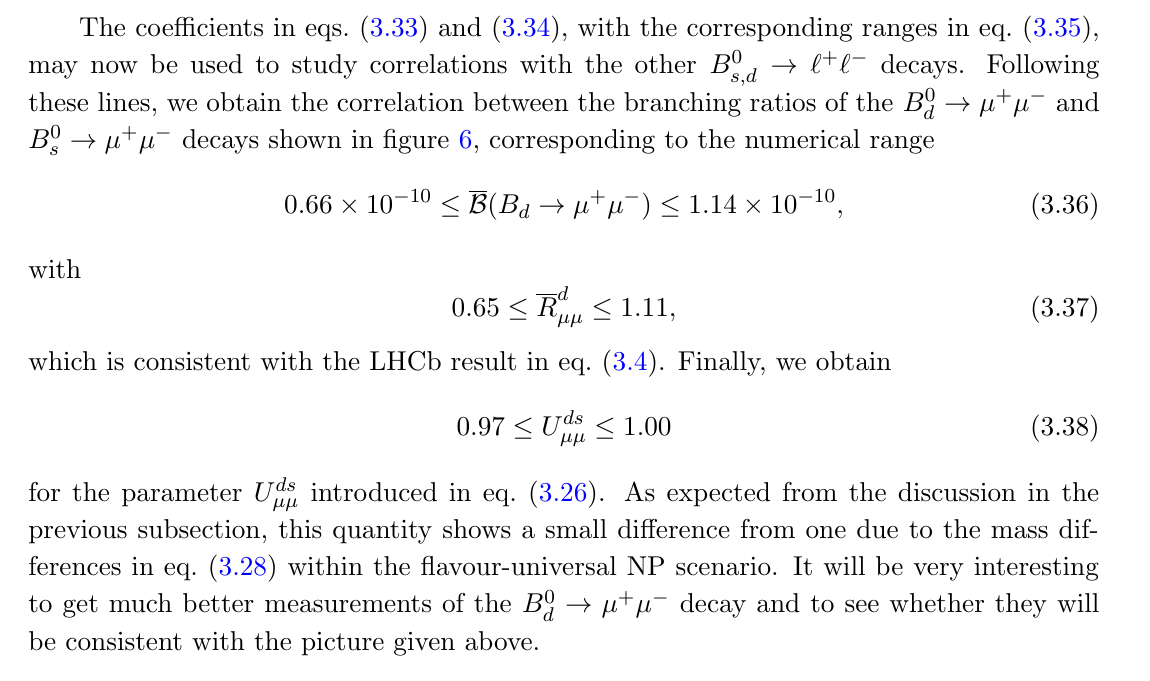
Figure 6 . Correlation between the branching ratios the considered (cid:13)avour-universal NP scenario. The vertical blue band gives the 1 (cid:27) range for the B 0 (cid:22) + (cid:22) (cid:0) branching ratio, while the green and red regions are obtained by varying s ! 1 and +1. The panels on the left- and right-hand sides correspond to positive and negative (cid:0) solutions for P s , (cid:22)(cid:22)